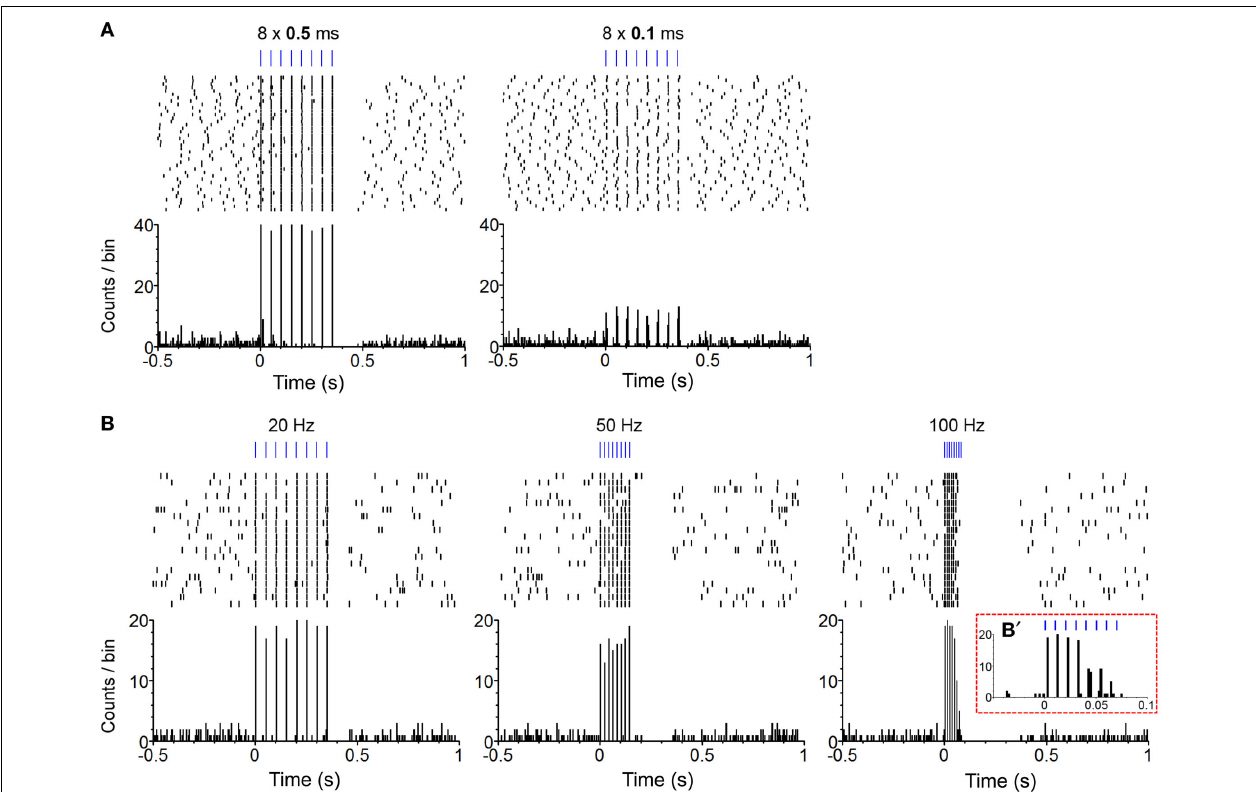
FIGURE 2 | Confirmation of phasic excitation of DA neurons by photo-pulse trains in freely-behaving mice. (A) The perievent spike rasters (top) and histograms (bottom) show photo stimulation-evoked firing of a neuron. Experimenter administered 40 photo trains (PI: 0.2mW; PF: 20Hz; PN: 8) of the 0.5 (left) and 0.1 (right) ms pulse-durations with the inter-train intervals varying between 10 and 15s. Bin = 5ms. (B) . The